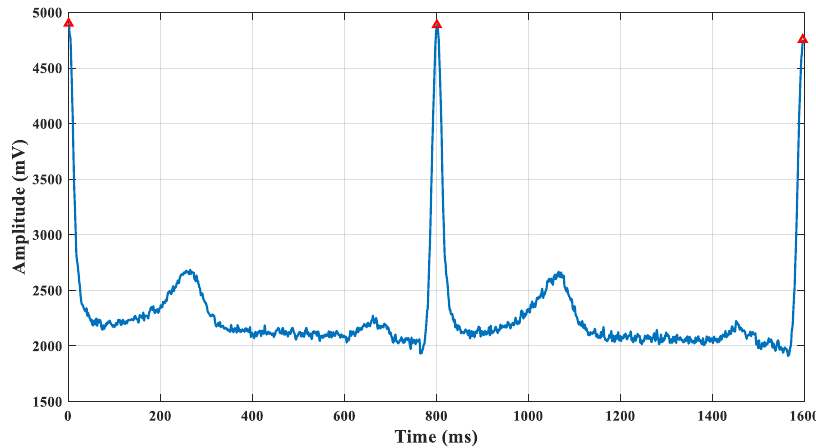
Figure 3. The method of signal segmentation.